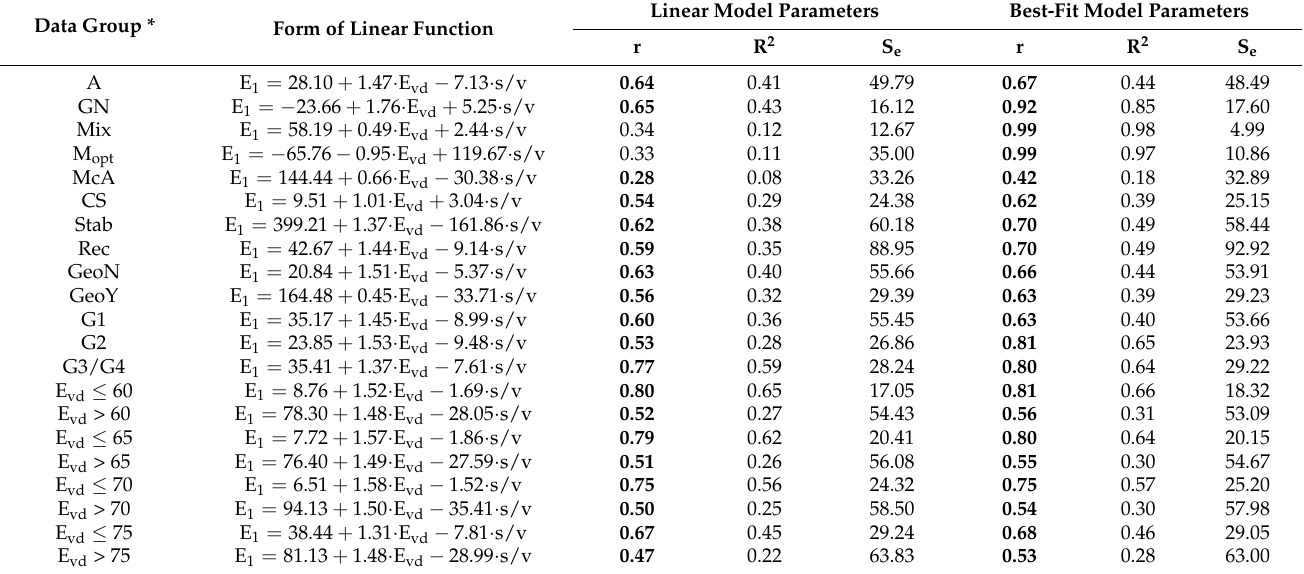
Table 4. Dependencies of dynamic deformation modulus E vd and ratio s/v (LFWD Zorn, type